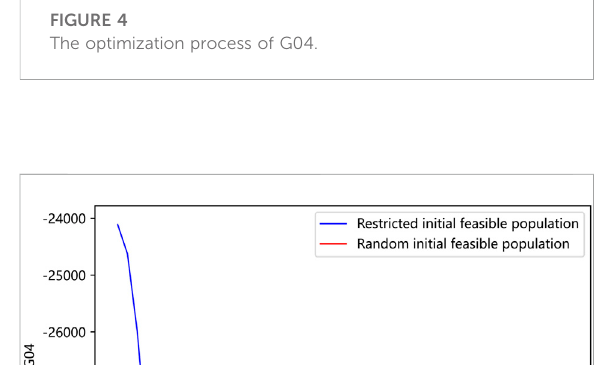
FIGURE 4 The optimization process of G04.